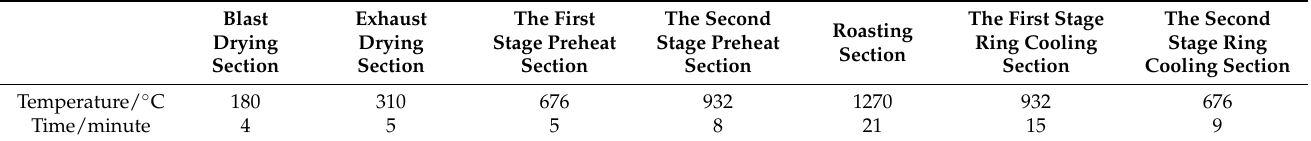
Table 3. Parameters of each stage of pellet roasting.